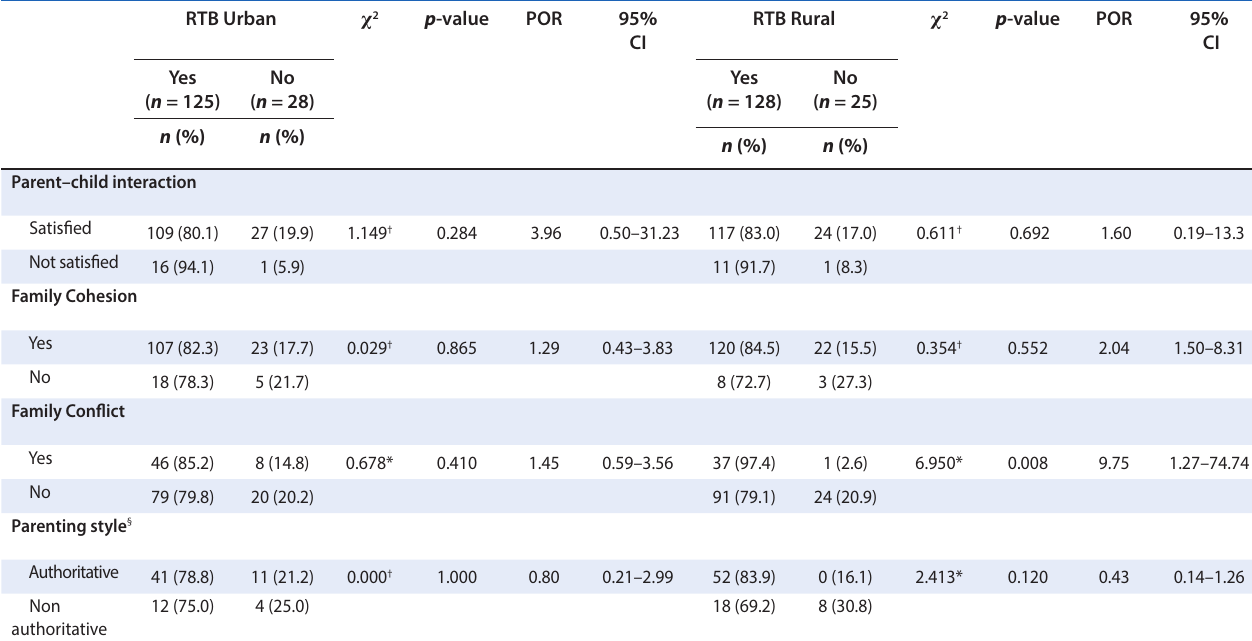
Table 3: Family characteristics comparison of risk taking behaviour among urban and rural